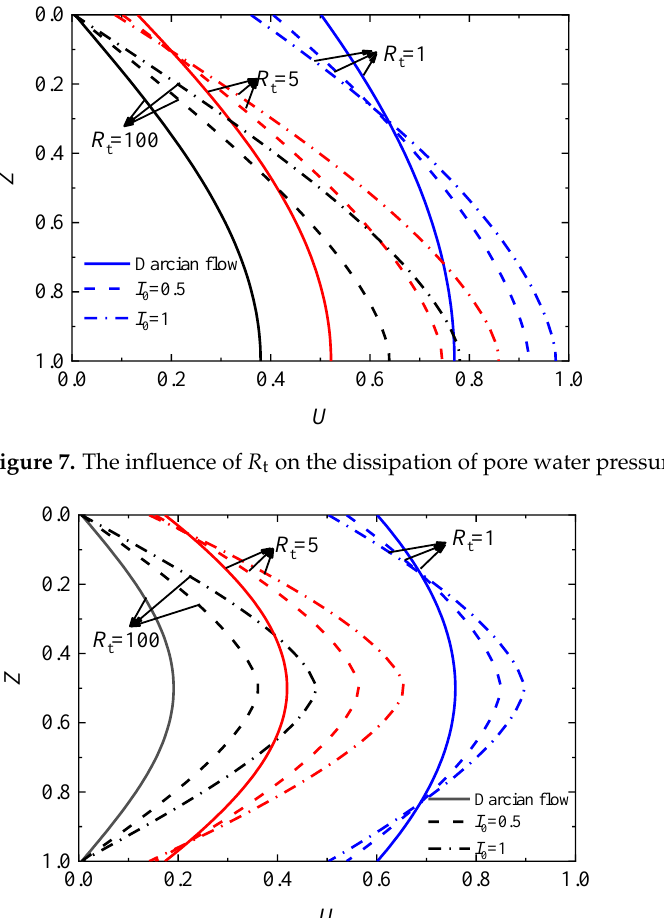
Figure 8. The influence of R t on the dissipation of pore water pressure R b = R t , T = 0.2. In order to investigate the influence of impeded drainage boundary parameters on the consolidation process, the curves of the dimensionless parameter I 0 on the average consolidation degree under the single-sided and double-sided impeded drainage bound- aries are depicted in Figures 9 and 10, respectively. It can be seen from the two figures that both the impeded drainage boundary parameters and flow parameters have a significant influence on the consolidation process. Under the same boundary drainage parameters, the consolidation rate slows with the increase of I 0 . As mentioned above, whether it is a single-sided or a double-sided impeded drainage boundary, there is a critical depth phe- nomenon in the dissipation of pore pressure, i.e., above the critical depth, the dissipation of pore pressure along the depth is faster than that of Darcy’s law when the non-Darcian flow is considered. However, it can be seen from Figures 9 and 10 that the overall dissipation rate of the foundation soil under the above parameters still shows that non-Darcian flow slows down the consolidation process, and the larger the value of I 0 , the more obvious the delay in the overall consolidation process. The authors suggest that the pore water pressure considering non-Darcian flow above the critical depth differs little from Darcy’s law. Then, the overall influence on the foundation soil is not enough to affect the overall consolidation rate of the soil layer after the pore pressure is averaged along with the